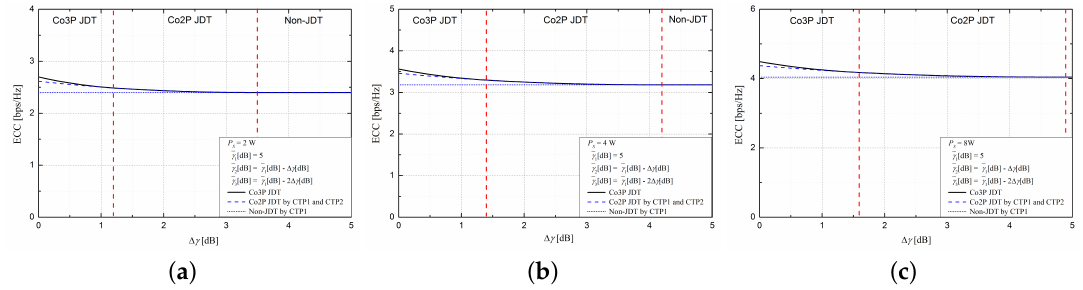
Figure 7. ECCs versus ∆ γ [dB] ( ¯ γ 1 = 5 dB): ( a ) P S = 2 W, ( b ) P S = 4 W, ( c ) P S = 8